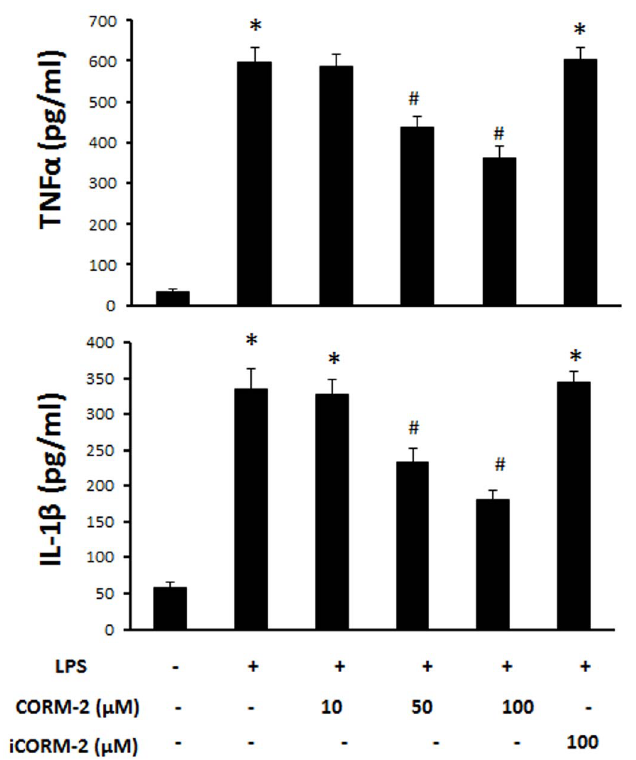
Figure 3. Effect of CORM-2 on the release of proinflammatory cytokines in LPS-treated IEC-6 cells. IEC-6 cells were pretreated with CORM-2 for 1 h and cells were washed and stimulated with 50 m g/ml LPS for 24 h. TNF- a (a) and IL-1 b (b) in the culture medium were measure using ELISA kits. Mean 6 SD from 3 independent experiments are shown. *ANOVA test, P , 0.05 when compared to control group (no treatment), # ANOVA test, P , 0.05 when compared to LPS alone group.